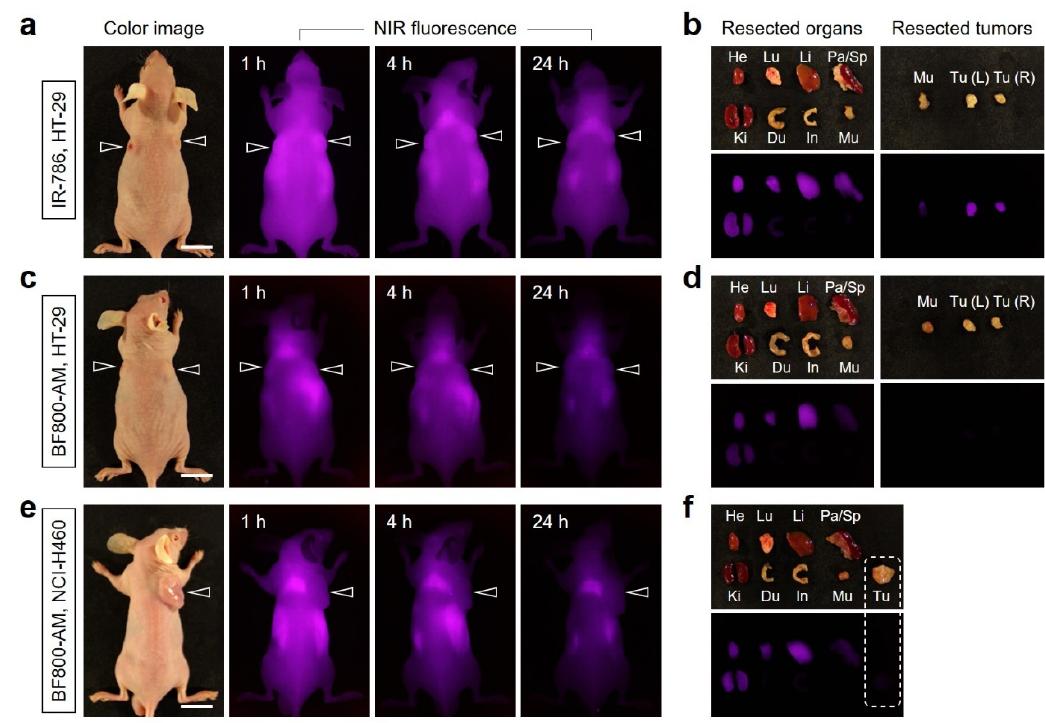
Figure 7. In vivo BAT and/or tumor uptake of IR-786 and BF800-AM in HT-29 or NCI-H460 tumor-bearing mice. Time-dependent NIR fluorescence imaging 24 h after injection of ( a ) IR-786 and ( c ) BF800-AM in HT-29 tumor-bearing mice. Resected organs and tumors imaged 24 h after injection of ( b ) IR-786 and ( d ) BF800-AM. ( e ) Time-dependent NIR fluorescence imaging 24 h after injection of BF800-AM in NCI-H460 tumor-bearing mice. ( f ) Resected organs and tumors imaged 24 h after injection of BF800-AM. The tumor sites are indicated by arrowheads. Abbreviations: Du, duodenum; He, heart; In, intestines; Ki, kidneys; L, the left; Li, liver; Lu, lungs; Mu, muscle; Pa, pancreas; R, the right; Sp, spleen; Tu, tumor. Scale bars = 1 cm. Images are representative of three independent experiments. All NIR fluorescence images have identical exposure times and normalization.